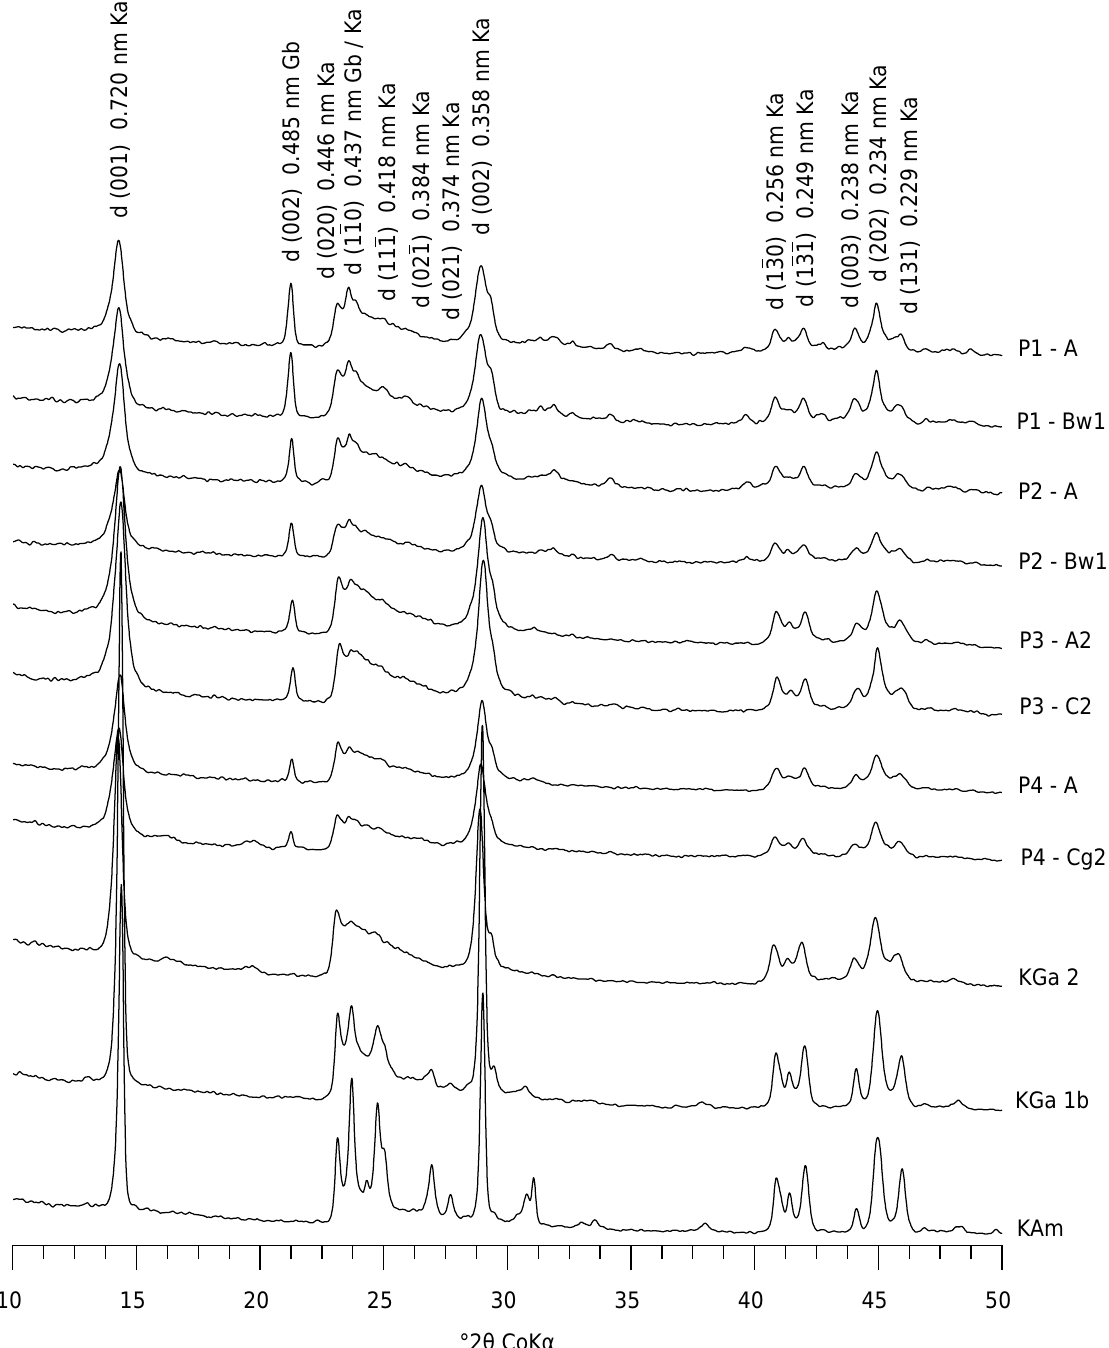
Figure 5. XRD patterns collected from Fe-free clay mineral (random powder). KGa 2 = high structural disorder kaolinite standard; KGa 1b = low structural disorder kaolinite standard; KAm = low structural disorder kaolinite from Amazônia; Ka = kaolinite; Gb =